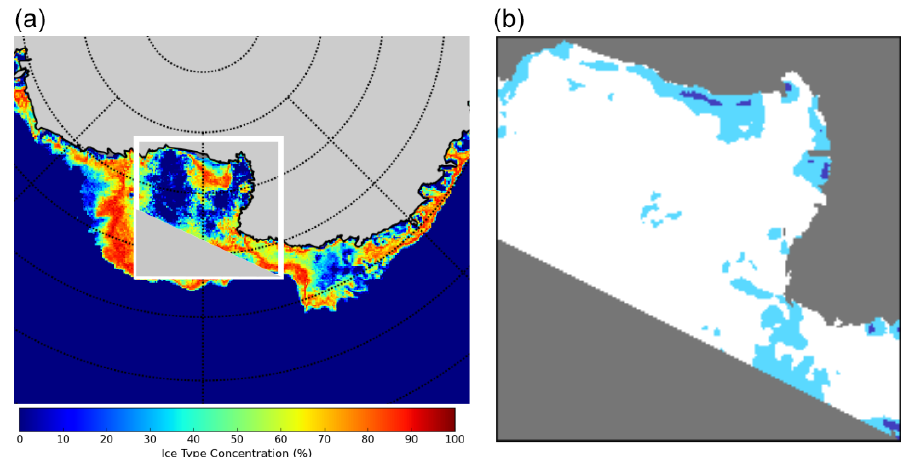
Figure 7. (a) Map of YI, 3 May 2017; (b) PSSM polynya map in the area indicated by the white rectangle in the YI map (dark blue: open water, light blue: thin ice, white: other ice, grey: masked-out area).